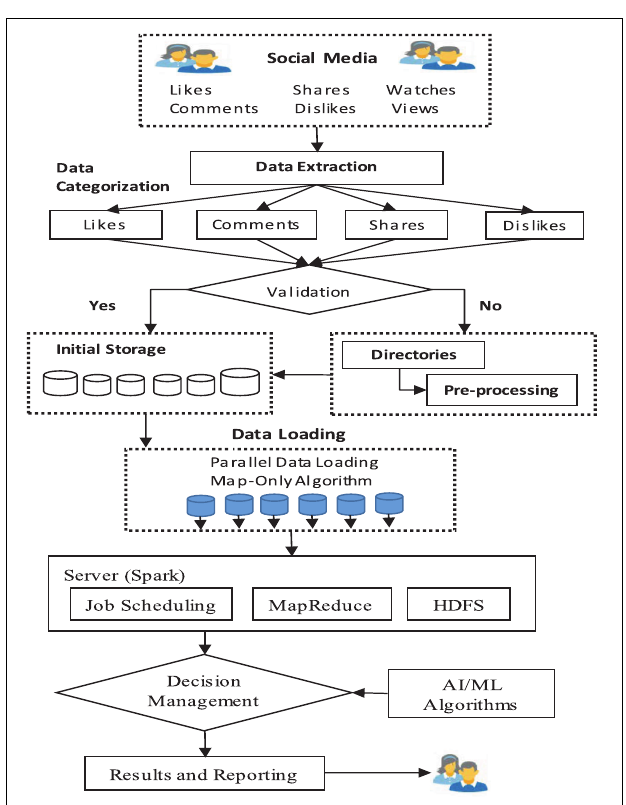
FIGURE 1 | Overview of the proposed